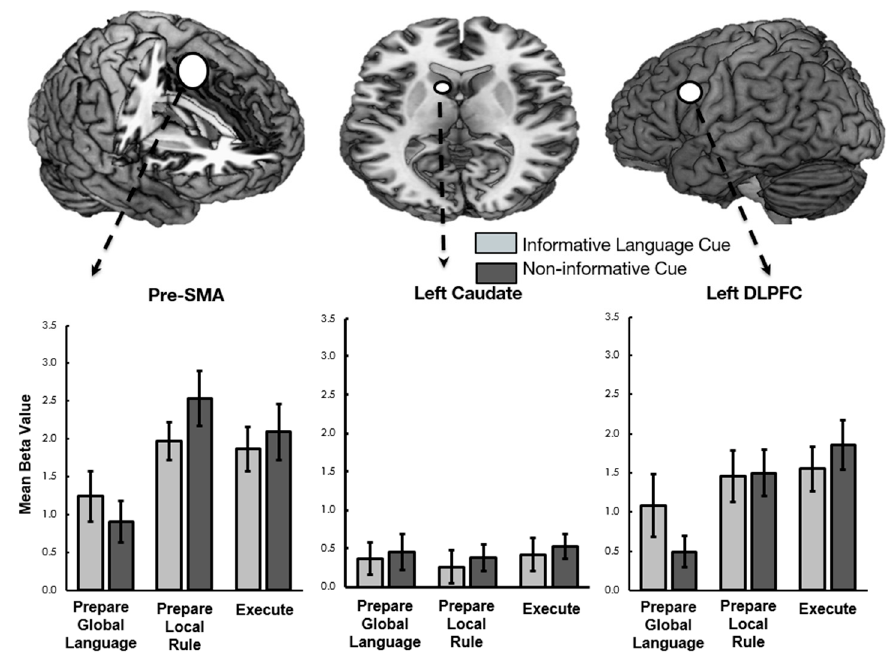
Figure 2. Mean beta weights extracted across the three task phases from three regions (pre-SMA, left caudate, left DLPFC).